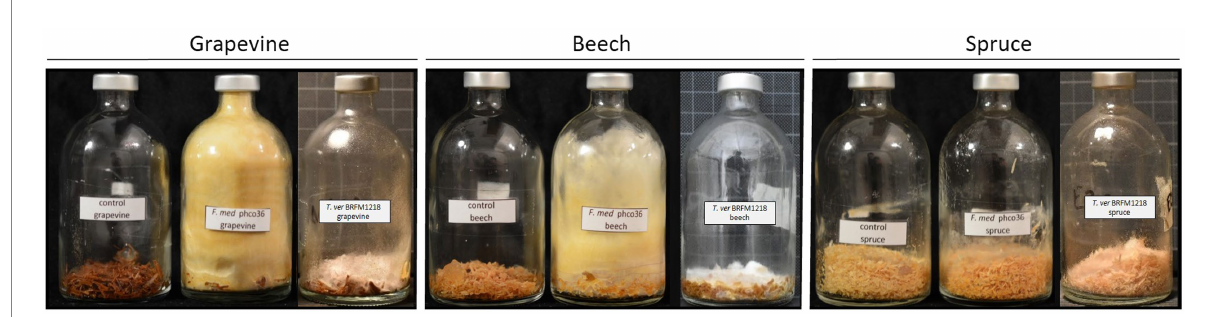
FIGURE 2 Control, Fmed ( F. mediterranea phco36) and Tver ( T. versicolor BRFM1218) cultures on grapevine, beech and spruce at the end of the cultures. Grapevine and beech cultures were stopped at 3 months, and spruce cultures were stopped at 2 months. A yellow and wolly mycelium was observed for Fmed whereas Tver mycelium remains white and at the bottom of the flask. On spruce, a slight coloration of sawdust and white mycelium are observed with Fmed, and no mycelum is observed with